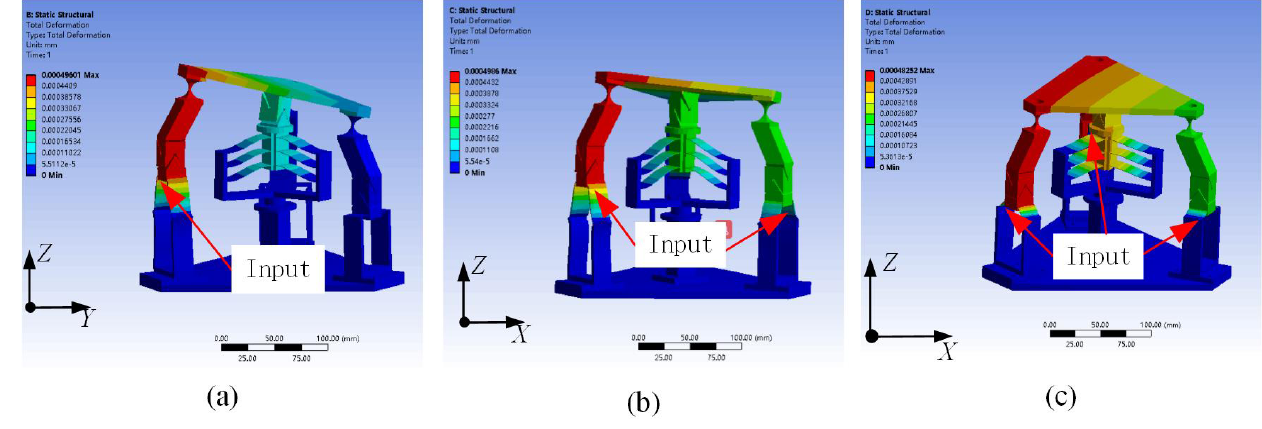
Figure 12. The deformation distribution, with (a) one actuator, (b) two actuators, and (c) three actuators, respectively.